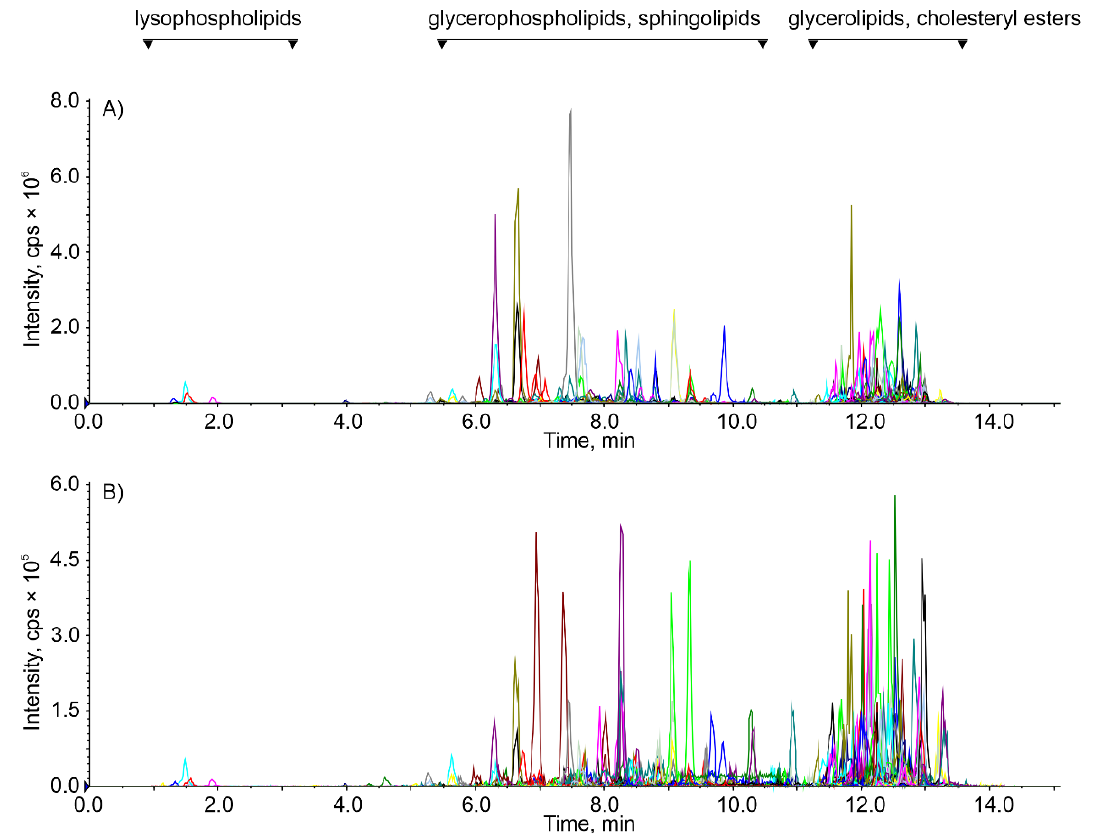
Figure 3. Chromatograms of samples D1R ( A ) and G3L ( B ) with different lipid profiles measured in positive ion mode. Each peak represents a selected MRM transition corresponding to a unique